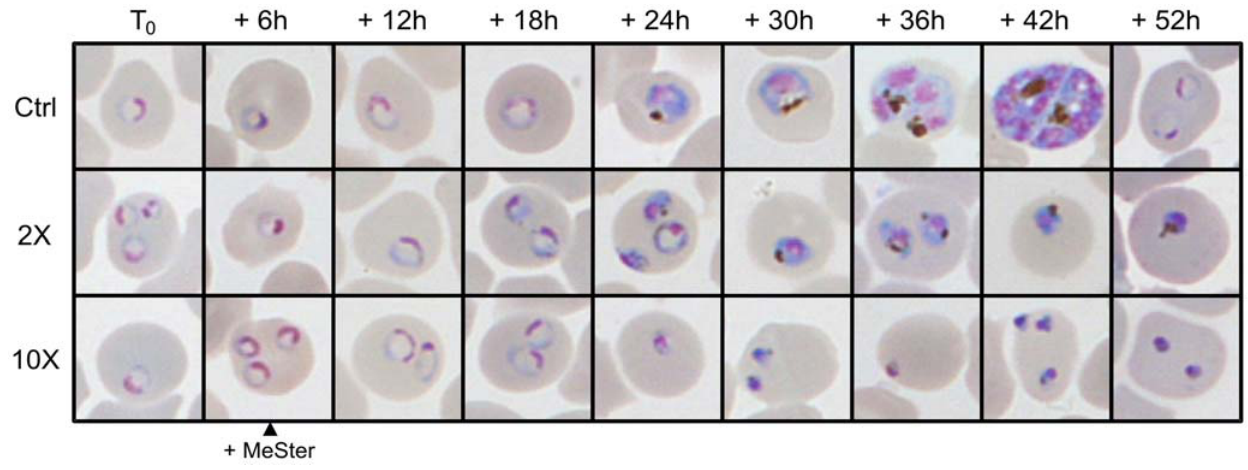
Figure 9. Effect of MeSter on parasite morphology. MeSter at 2-fold and 10-fold the IC 50 was added to P. falciparum 6 hrs after synchronization (T 0 ). Giemsa-stained blood smears were performed every 6 hrs until reinvasion of the control dish 52 hrs later. Representative images are shown.